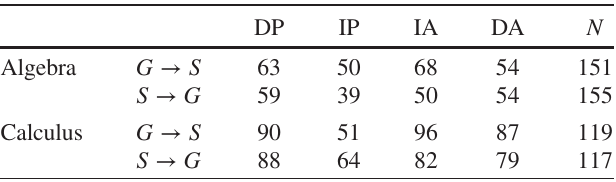
TABLE III. Percentage of correct answers per translation and function type. The last column shows N , the number of student answers per item type.